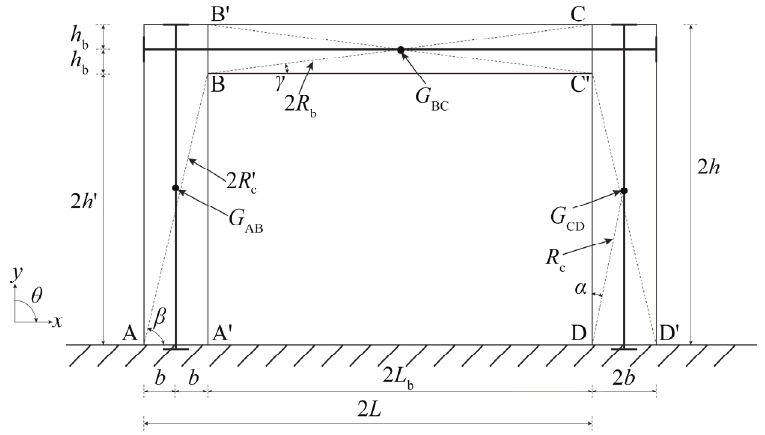
Figure 1. Rigid body model of prestressed concrete rocking frame (PCRF).